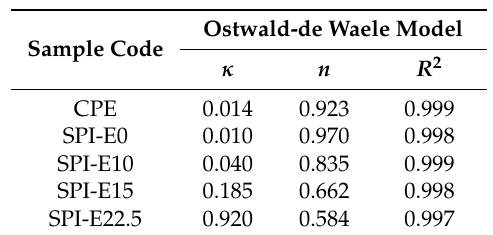
Table 1. Rheological parameters of the Ostwald-de Waele model for the film-forming solutions.